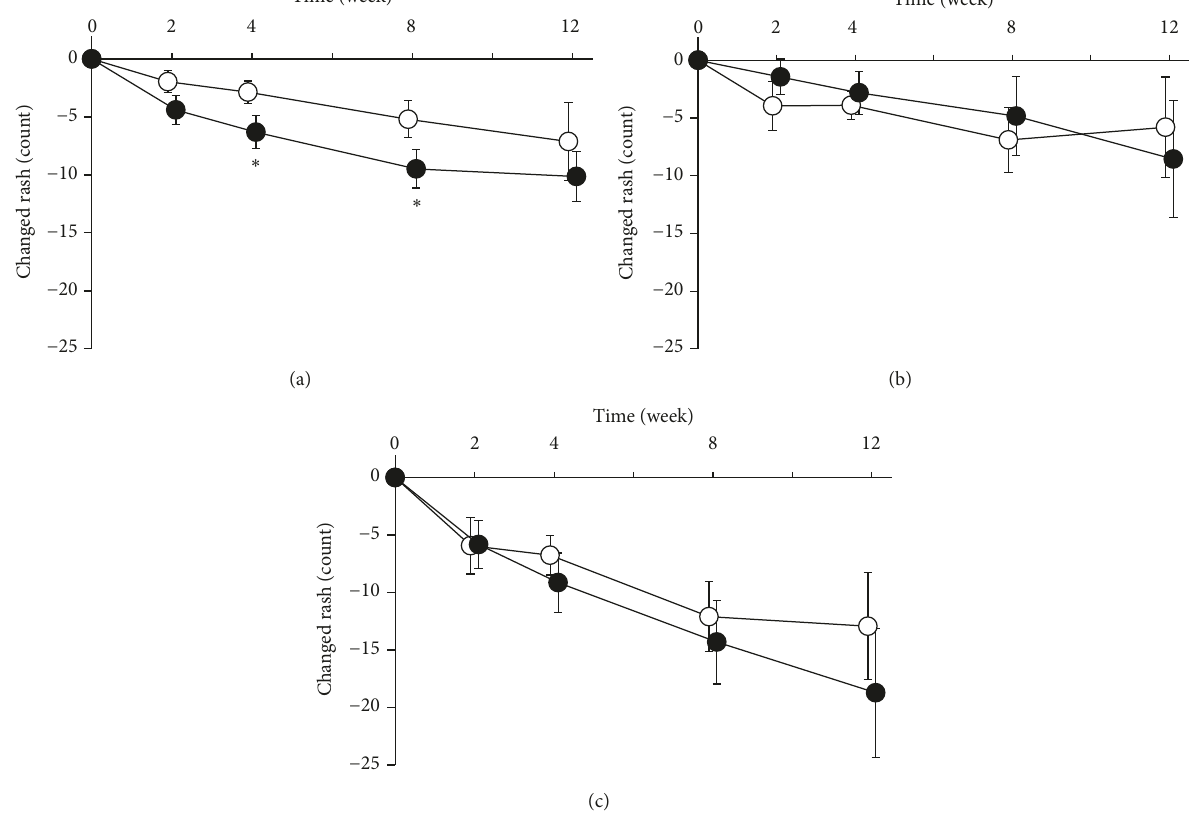
Figure 1: Effect of Keigairengyoto on the number of acne rashes . Patients were randomized into a conventional treatment group (control group, white circles) and a group with conventional treatment and Keigairengyoto (KRT group, filled circles), and they were treated for 12 weeks. The amount of inflammatory and noninflammatory acne on the face was counted at baseline (study entry) and at weeks 2, 4, 8, and 12. Time- dependent changes of inflammatory (a), noninflammatory (b), and total (c) acne are shown as a reduction in the number of the respective rashes. Data are presented as the mean ± standard error. The number of patients at the time of each control and KRT group evaluation is as follows: pretreatment: control 28 and KRT 24; week 2: 24 and 23; week 4: 20 and 22; week 8: 21 and 19; and week 12: 16 and 14. ∗ P < 0.05, Wilcoxon rank-sum